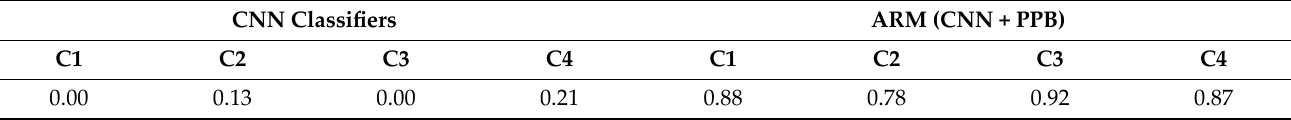
Table 9. The accuracies for scenario